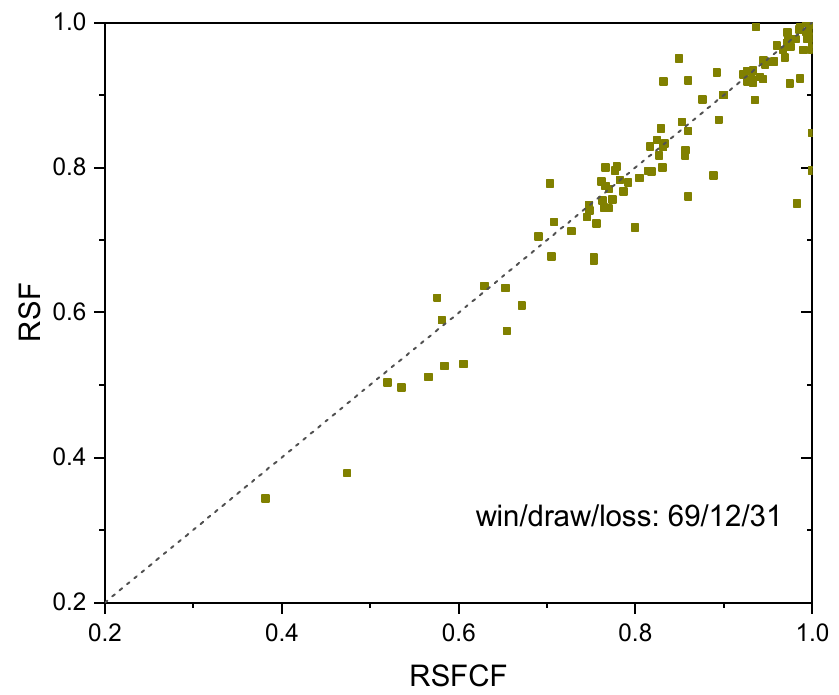
Figure 9. Comparison of random Shapelet forest classifiers with or without canonical time series features (RSFCF versus RSF) in terms of accuracy over 112 UCR datasets.